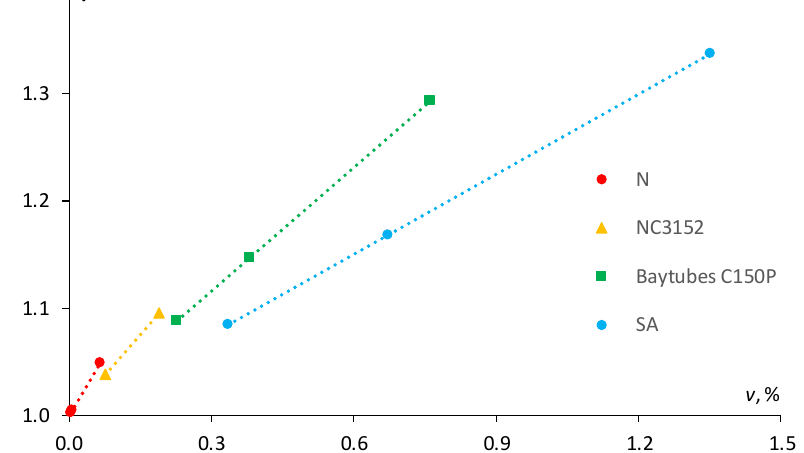
Figure 5. Tortuosity factor vs. the filler volume fraction for the epoxy filled with different MWCNTs (indicated in the legend). Dots—calculation by Equation (5), lines—linear approximation.